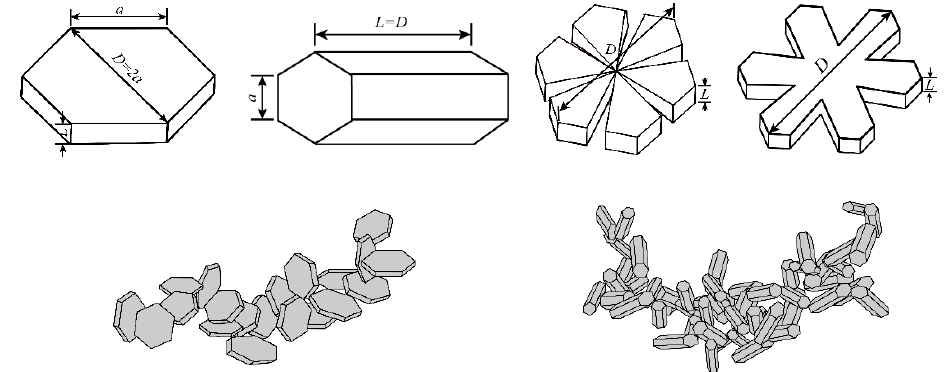
Figure 1. Ice particle geometries considered in this study. From left to right: ( top ) hexagonal plate, hexagonal column, sector-like plates, stellar crystal with broad arms, ( bottom ) aggregate of plates, and aggregate of columns.